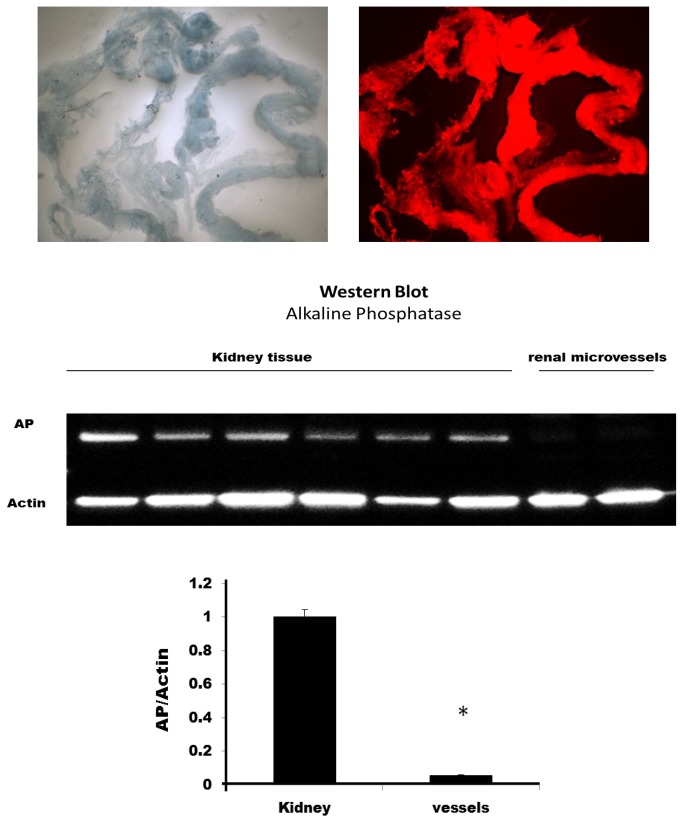
Typical appearance of the isolated renal microvessels.The upper left panel presents appearance of the vessels under white light illumination. The upper right panel presents the appearance of the vessels with excitation of 550 nm, emission of 610 nm. The vessels that were stained with Evans blue in the isolation procedure exhibit red fluoresce while the adherent tubules do not fluoresce. The lower panel compares alkaline phosphatase activity which is highly expressed in the proximal tubules in renal homogenates versus that seen in the renal microvessel preparation. * indicates a significant difference from control.